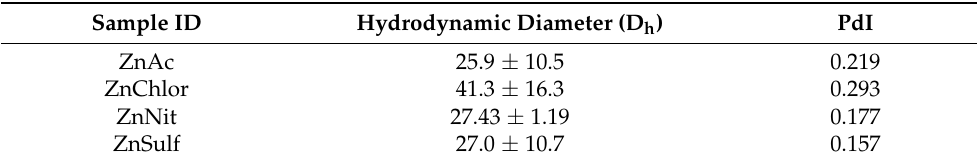
Figure 6. Size distribution diagram for the sample prepared from: ( a ) zinc acetate, ( b ) zinc nitrate, ( c ) zinc chloride, ( d ) zinc sulfate. Table 7. Results from